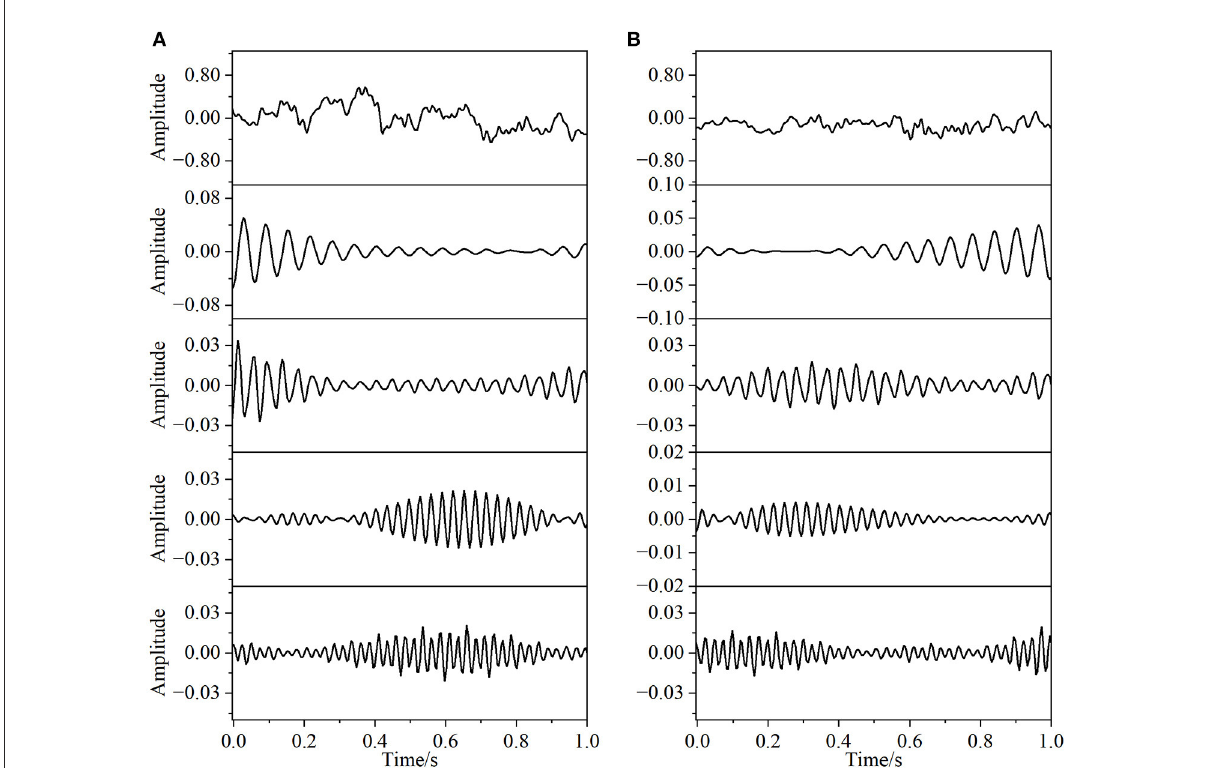
FIGURE3 Coiflets wavelet packet transform of the signal (from top to bottom, the normalized signal after pre-processing, extracted after wavelet packet transform for 16, 24, 32, and 40 Hz bands, respectively). (A) EEG, (B)